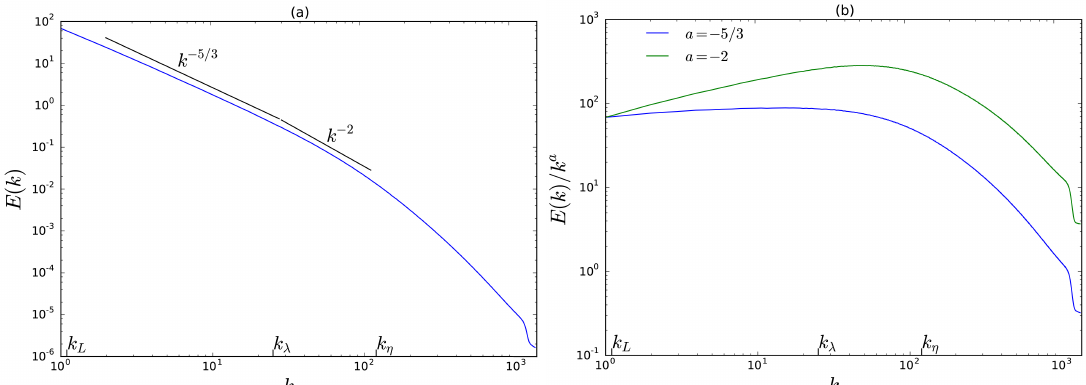
Figure 4. ( a ) energy spectrum E ( k , t ) of the velocity field of DNS of Burgers turbulence. The small wavenumbers (largest scales) show nearly Kolmogorov-like behavior ∼ k − 5/3 whereas a shock-like behavior k − 2 can be perceived for a small band of larger wavenumbers at the edge of the inertial range. The dissipation range exhibits an exponential decay of the energy spectrum. Inertial range limits have been indicated by k L and k η and are explained in detail in the plain text; ( b ) compensated energy spectra E ( k ) / k a . The blue lines correspond to the Kolmogorov case a = − 5/3 and the green line to the shock case a = − 2. Constant lines in the plot indicate scaling behavior of the spectrum. The spectrum for smaller wavenumbers is quite close to the Kolmogorov spectrum. Larger wavenumbers in the inertial range at around 60 < k < 80 show more of a shock-like spectrum; in addition, the compensated spectrum is not as flat as in the Kolmogorov